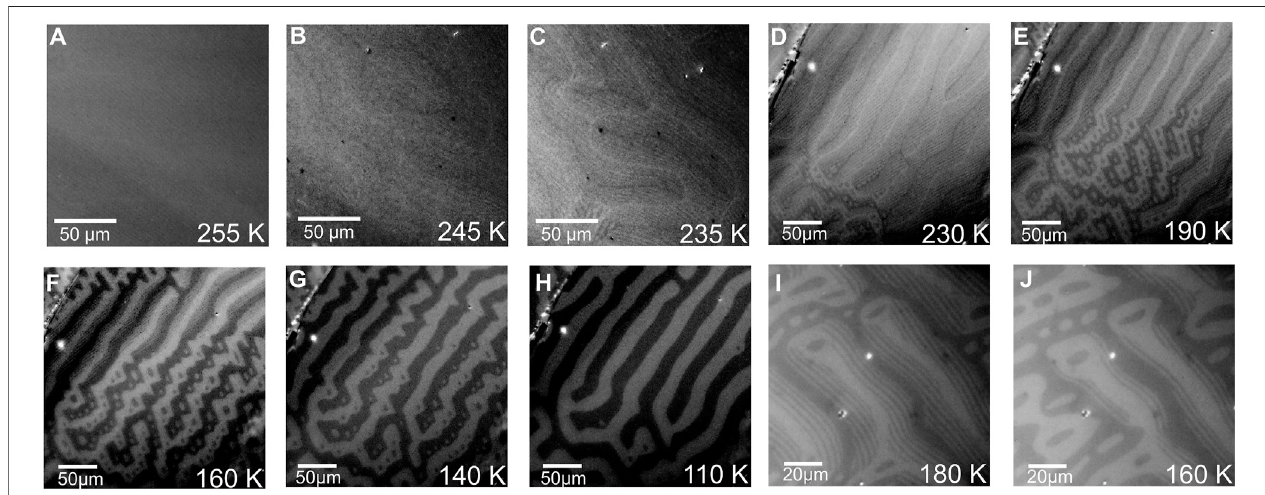
FIGURE3|(A – C) Appearance ofthe magnetic domain ofDyMn 6 Sn 6 crystal from255to235 K. (D – H) Magnetic domains ofDyMn 6 Sn 6 crystalfrom 230to110 K. (D – G) Type-II domains transform into type-I domains from 230 to 140 K. (I,J) Type-II domains of DyMn 6 Sn 6 crystal from 180 to 160